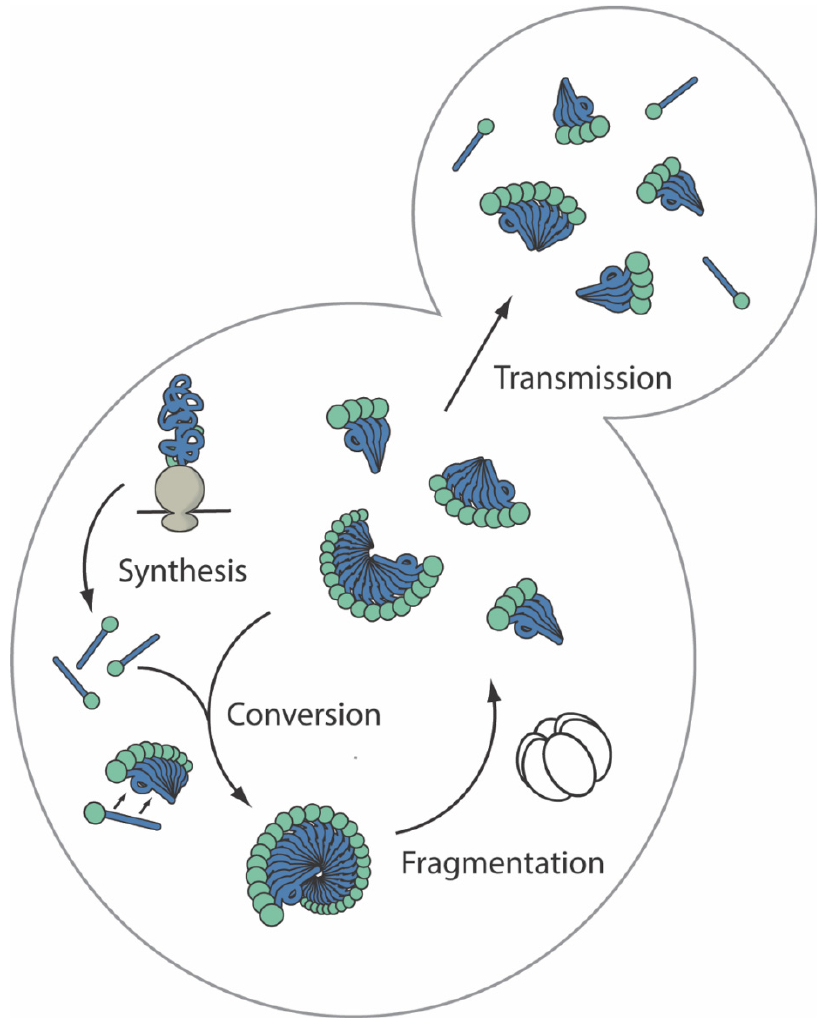
Figure 2. The [ PSI + ] prion propagation cycle in the budding yeast Saccharomyces cerevisiae . Newly synthesized Sup35 (green and blue ball and stick) from translating ribosomes (gray) forms prions via interaction of its prion-determining domain (blue), leading to its conformation conversion (linear to corkscrew) and the display of its translational release domain (green circle) on the surface of the protofibril. Conversion occurs de novo at low frequency when overexpressed (not shown) or through association with existing linear prion complexes (ball and corkscrew wheels) via the prion- determining domain (blue) through templated conversion at particle ends (double arrow), increasing particle size and reducing particle mobility. Fragmentation of particles by the disaggregase Hsp104 (white hexamer of ellipses) in cooperation with the Hsp70/40 (Ssa1/2) chaperone system (not shown) increases particle number, amplifying the abundance of conversion surfaces available for templating, decreasing the size of these particles and increasing their mobility (green and blue ball and corkscrew wheel fragments). Small mobile particles transmit into daughter cells at cell division maintaining the prion in the cell population.